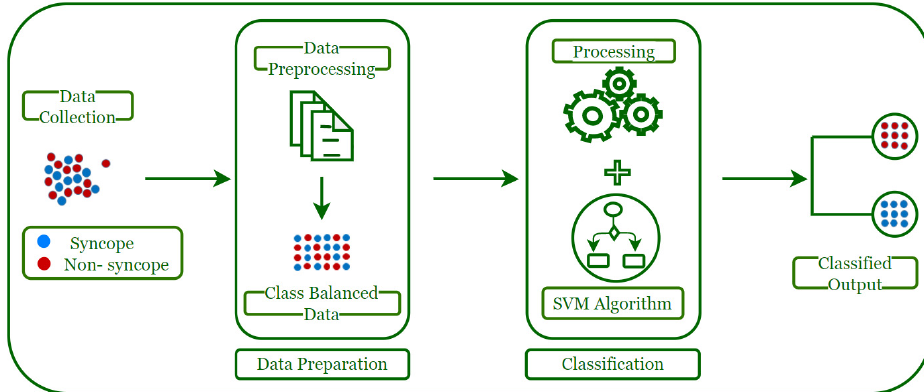
Figure 1. Flow Diagram of the Working of Model.